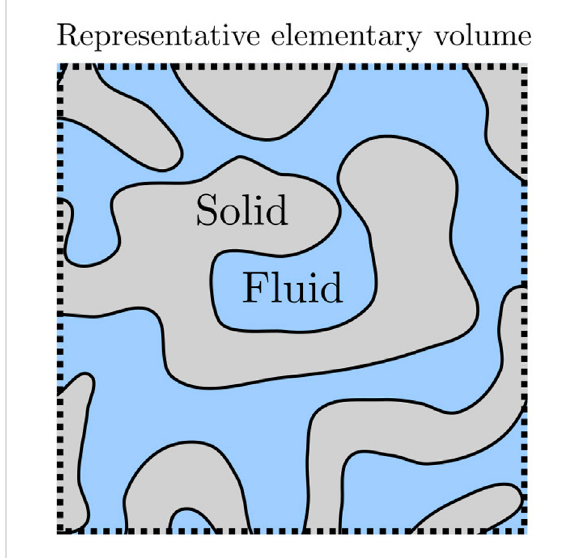
FIGURE 1 A single-phase and -component fl uid in a porous medium. The fl uid-solid interfaces can have complex shapes and the volumes can be on the